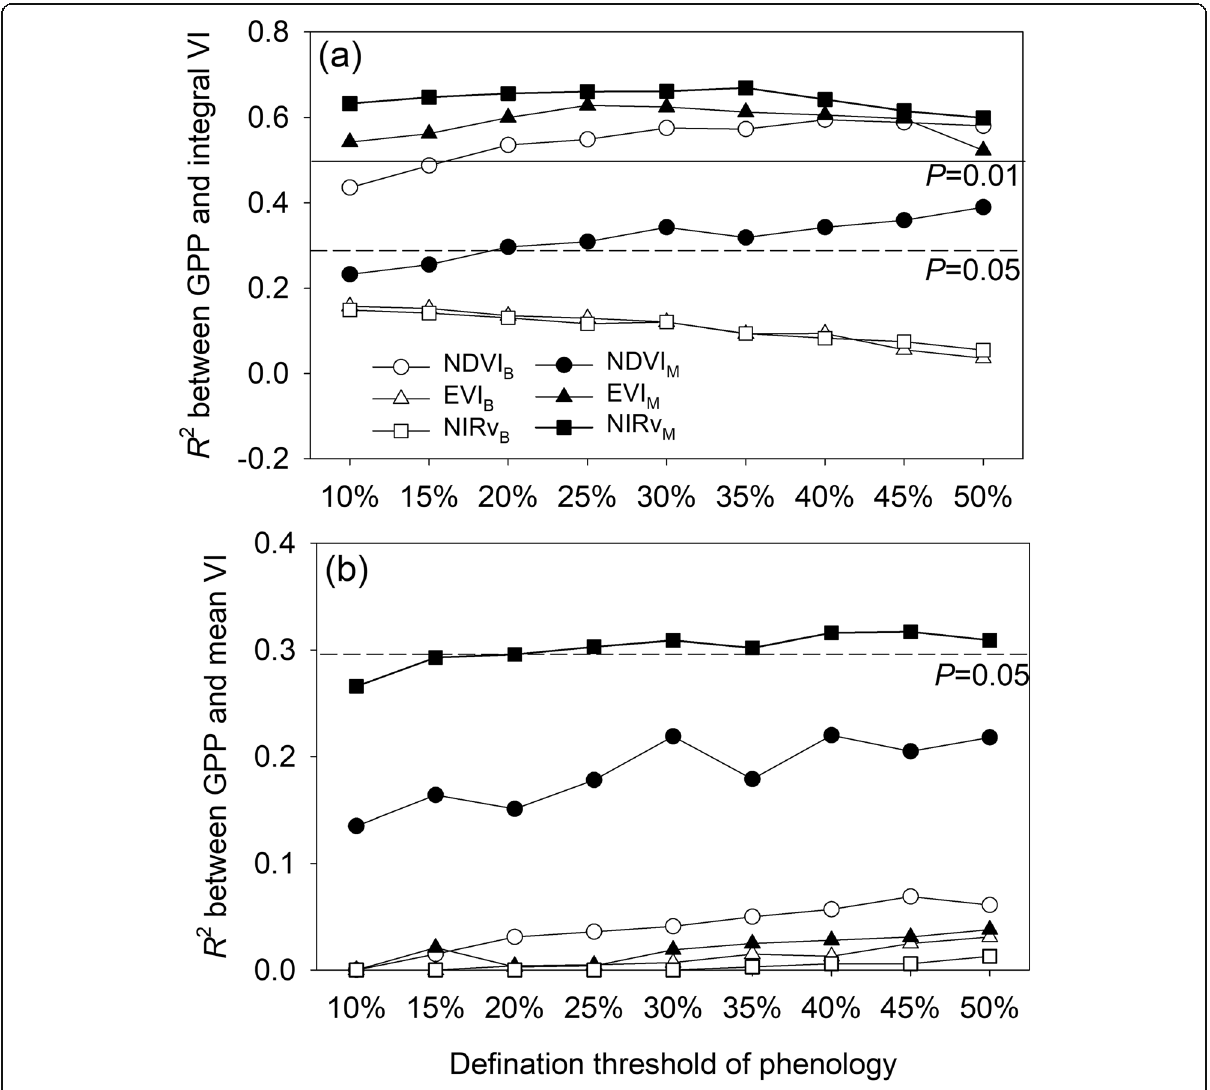
Fig. 3 Determination coefficient ( R 2 ) of the regression of annual gross primary production (GPP) against the integral vegetation indices (VIs) or mean VIs for the growing-season defined by different thresholds. NDVI B : broadband normalized difference vegetation index, EVI B : broadband enhanced vegetation index, NIRv B : broadband near-infrared albedo of vegetation, NDVI M : MODIS normalized difference vegetation index, EVI M : MODIS enhanced vegetation index, NIRv M : MODIS near-infrared reflectance of